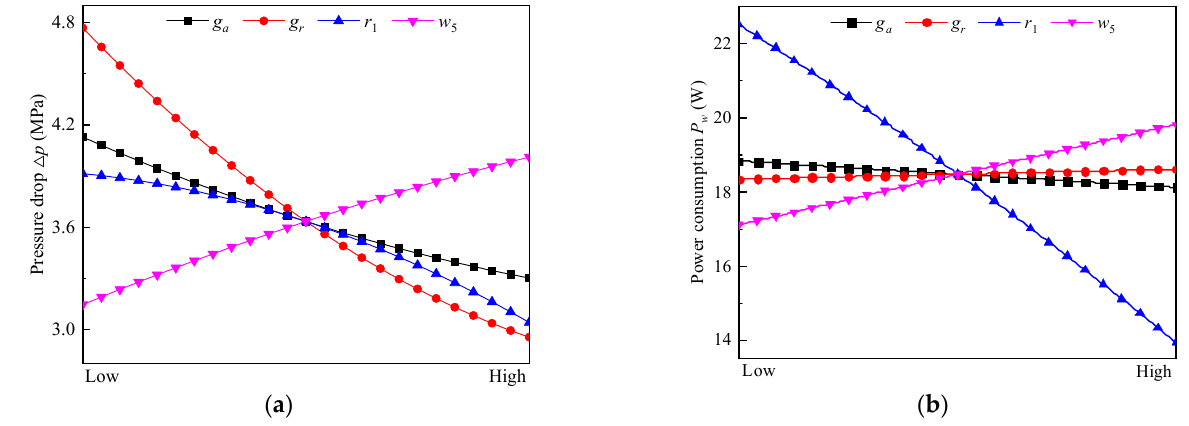
Figure 7. Main effect diagram: ( a ) design variables on Δ p , ( b ) design variables on P w.